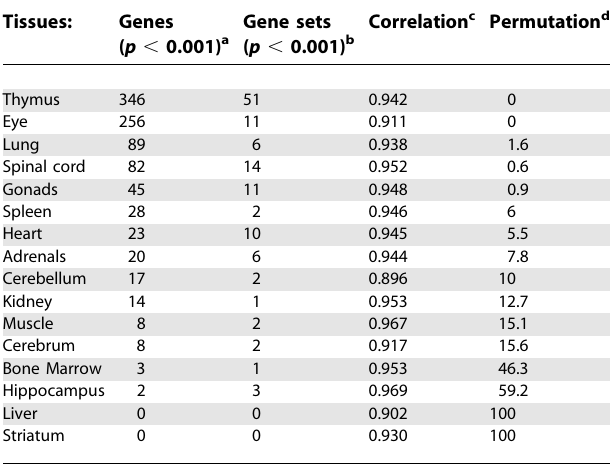
Table 1. Age-Regulated Genes